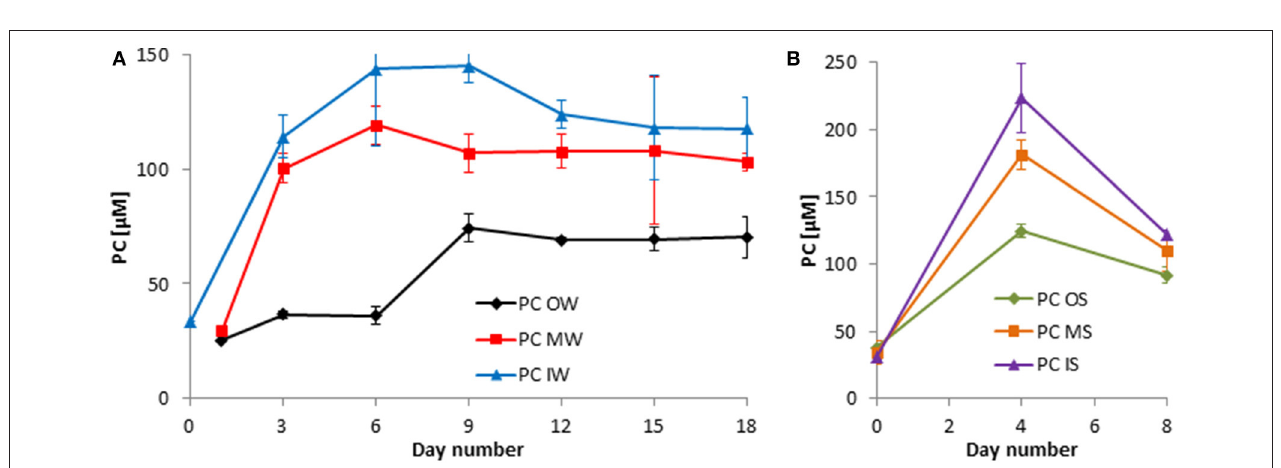
FIGURE 7 | Development of the particulate carbon (PC) in the tanks of the experiment from winter 2013 (A) and summer 2014 (B). Mean values and standard deviations of the three replicate tanks are